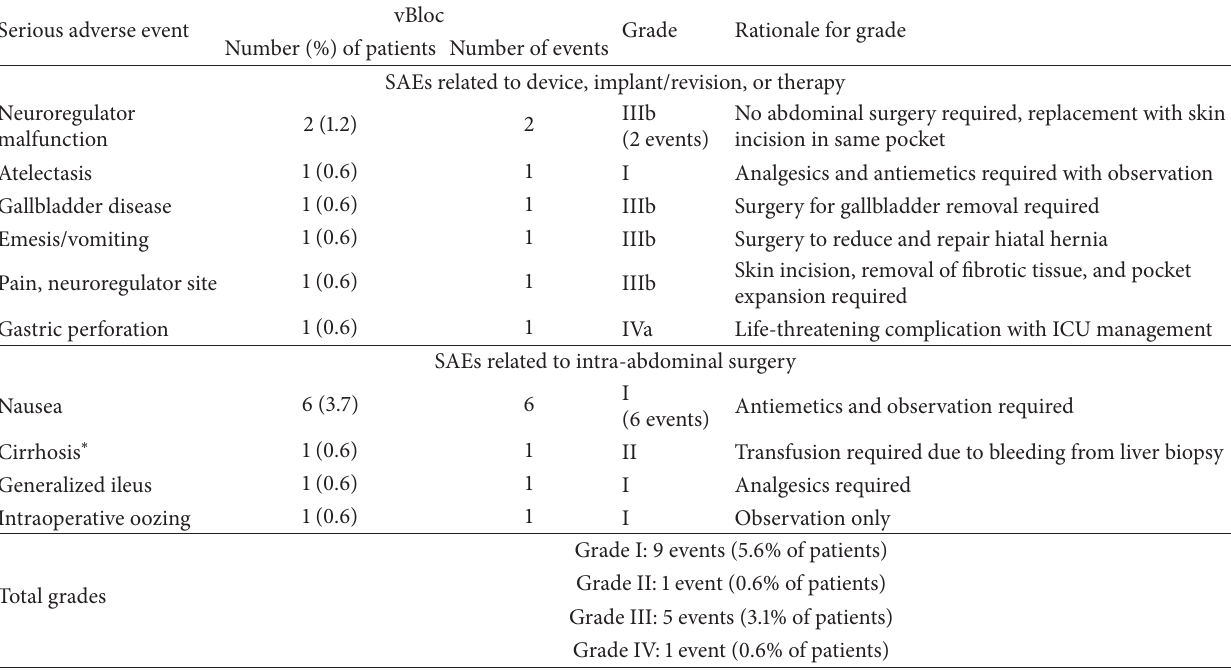
Table 4: Serious adverse events graded as surgical complications according to the Clavien-Dindo Scale through 18 months in the vBloc group. vBloc Serious adverse event Grade Rationale for grade Number (%) of patients Number of events SAEs related to device, implant/revision, or